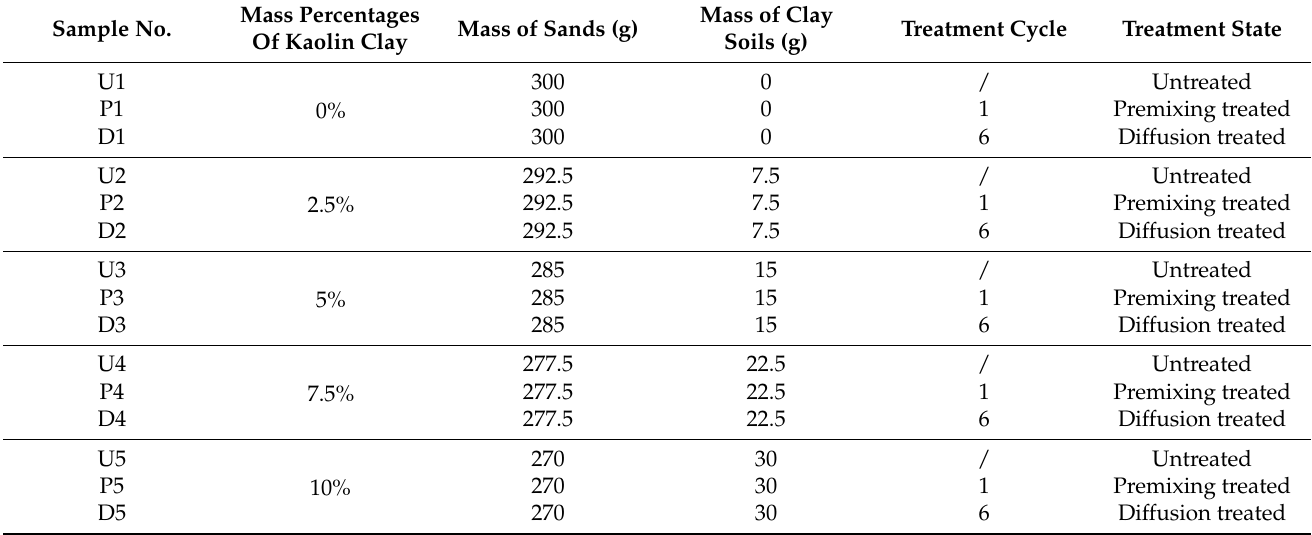
Table 1. Sample arrangement for